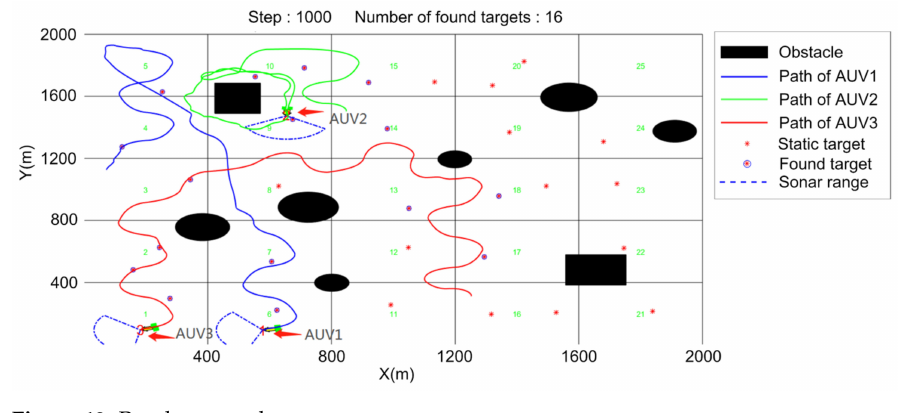
Figure 12. Random search.